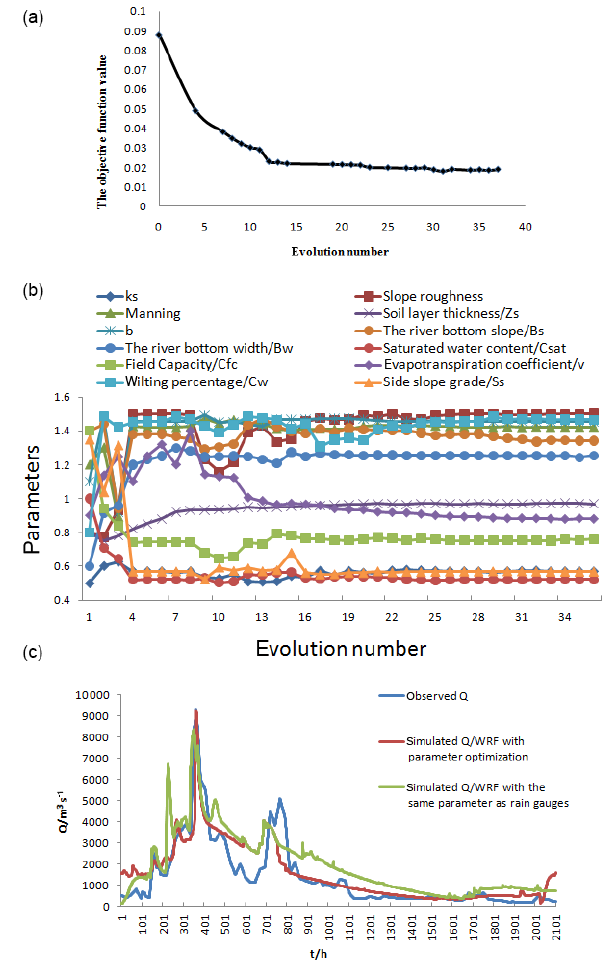
Figure 6. Parameter optimization results of the Liuxihe model for the LRB with WRF